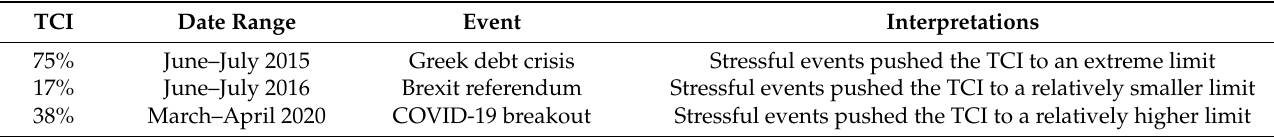
Figure 5. TCI over the years (from June 2015 to February 2022). Table 4. Events linked with relatively higher TCI